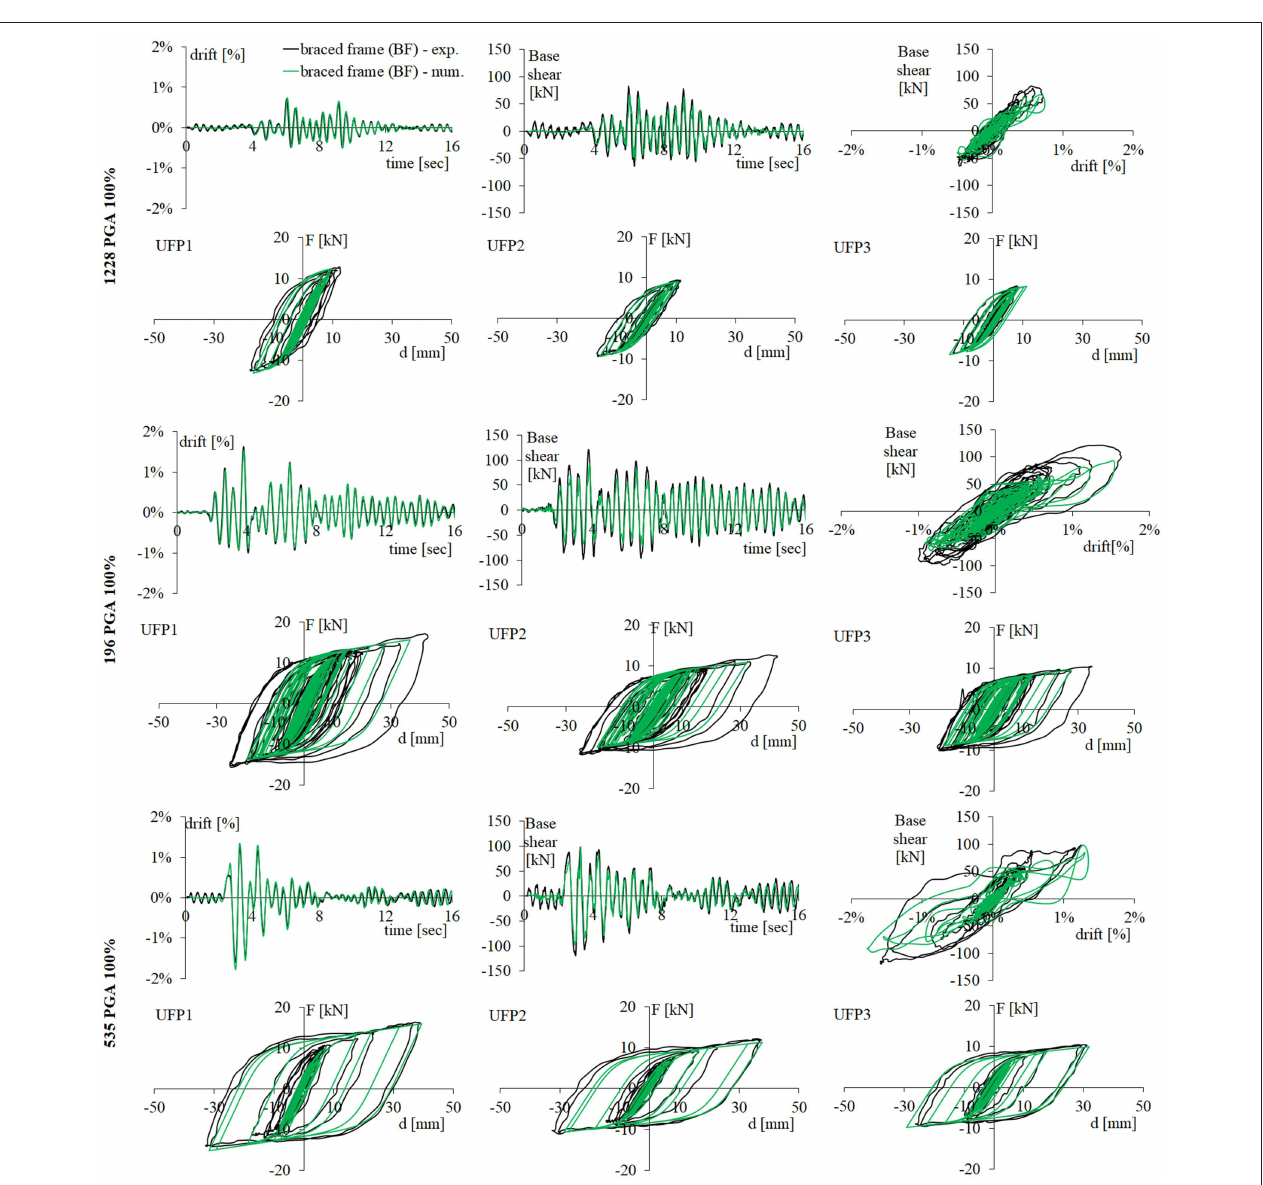
FIGURE 12 | Experimental and numerical results of BF model obtained for seismic inputs 1228, 196, and 535 at 100% of PGA: time-histories of base shear and total drift, base shear vs. total drift and hysteretic cyclic behavior of UFPs.